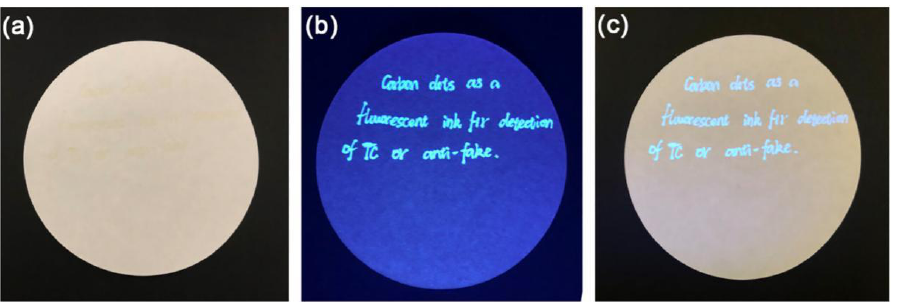
Figure 9. Photographic images of articles with hand-written characters using N-CDs as a fluorescent ink under day light ( a ), UV light ( b ) and both of them ( c ). Adapted with permission from. Zhao et al., 2020, Copyright 2020. Reproduced with permission from Elsevier [59].